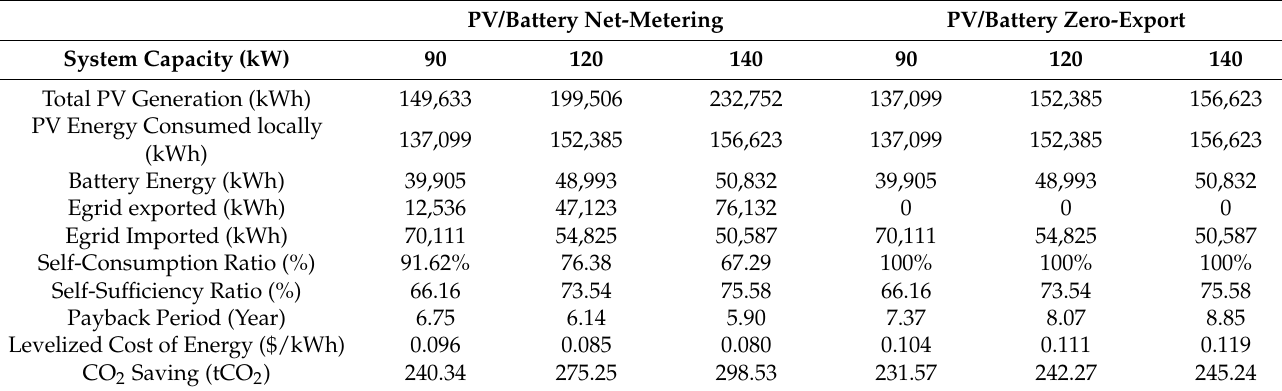
Table 8. Performance of EV charging station with PV system with battery. PV/Battery Net-Metering PV/Battery